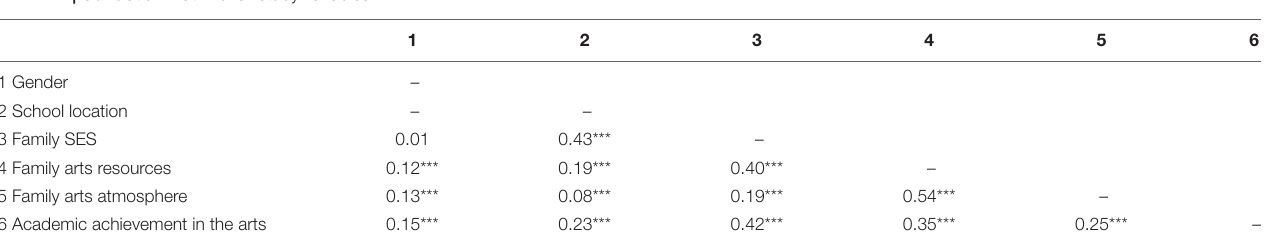
TABLE 2 | Correlation matrix of all study